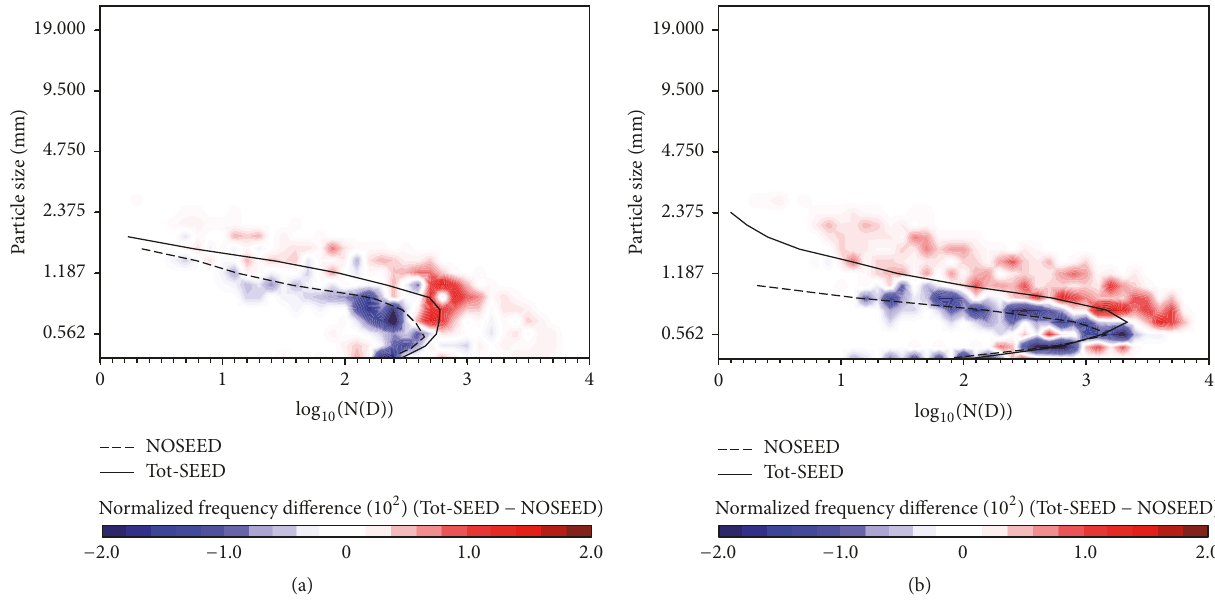
Figure 12: Normalized frequency difference from the PARSIVEL between NOSEED (dashed) and Tot-SEED (solid) at YP for (a) EXP2 and (b)